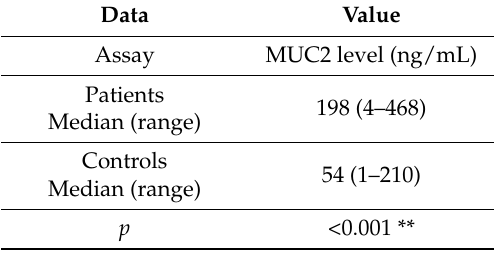
Table 2. The values of membrane-bound mucin 2 ( MUC 2) in patients with breast cancer and healthy